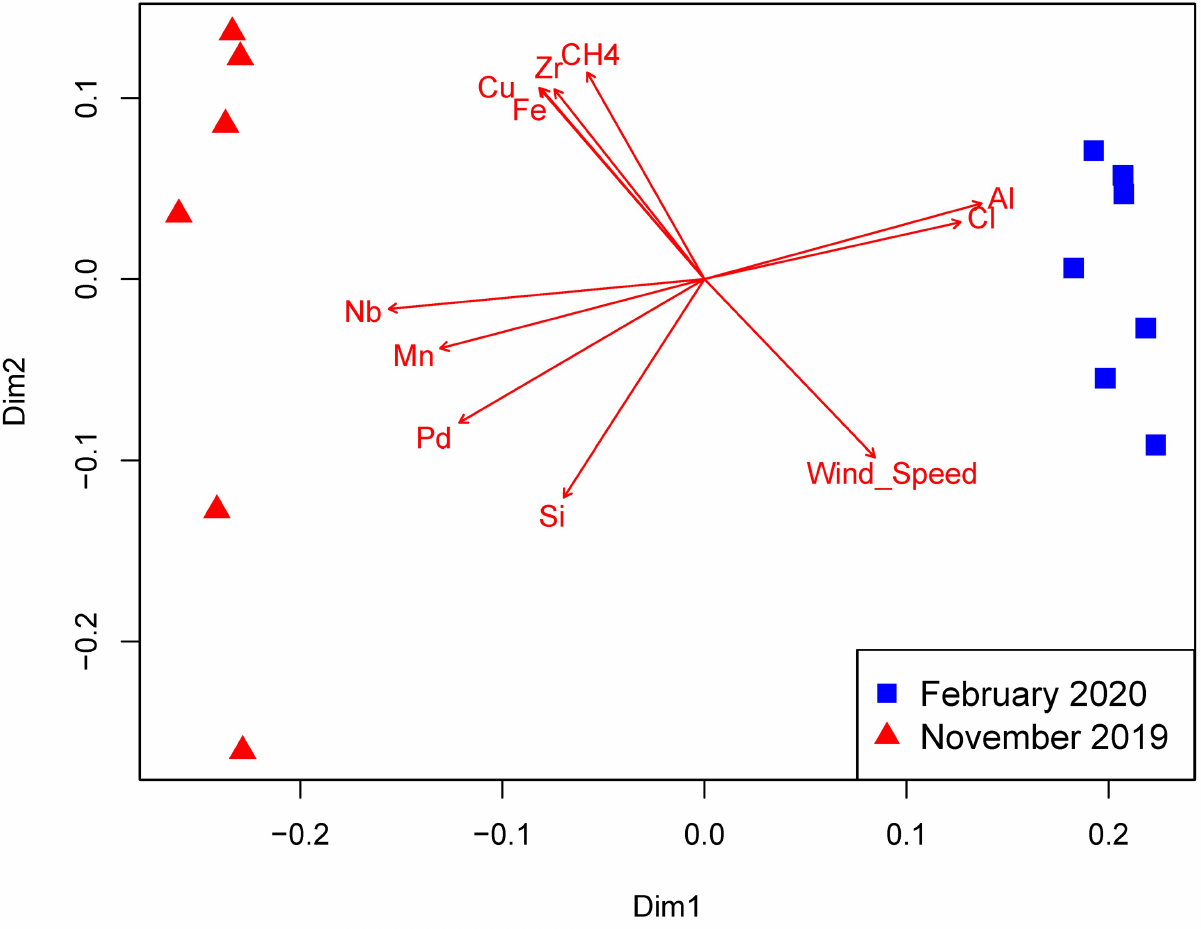
Figure 7. PCoA (principal coordinate analysis) plot of fungal communities. Environmental factors that have significant correlation with the ordination (with p value lower than 0.01 and R-square value larger than 0.5) based on permutation tests are shown as red